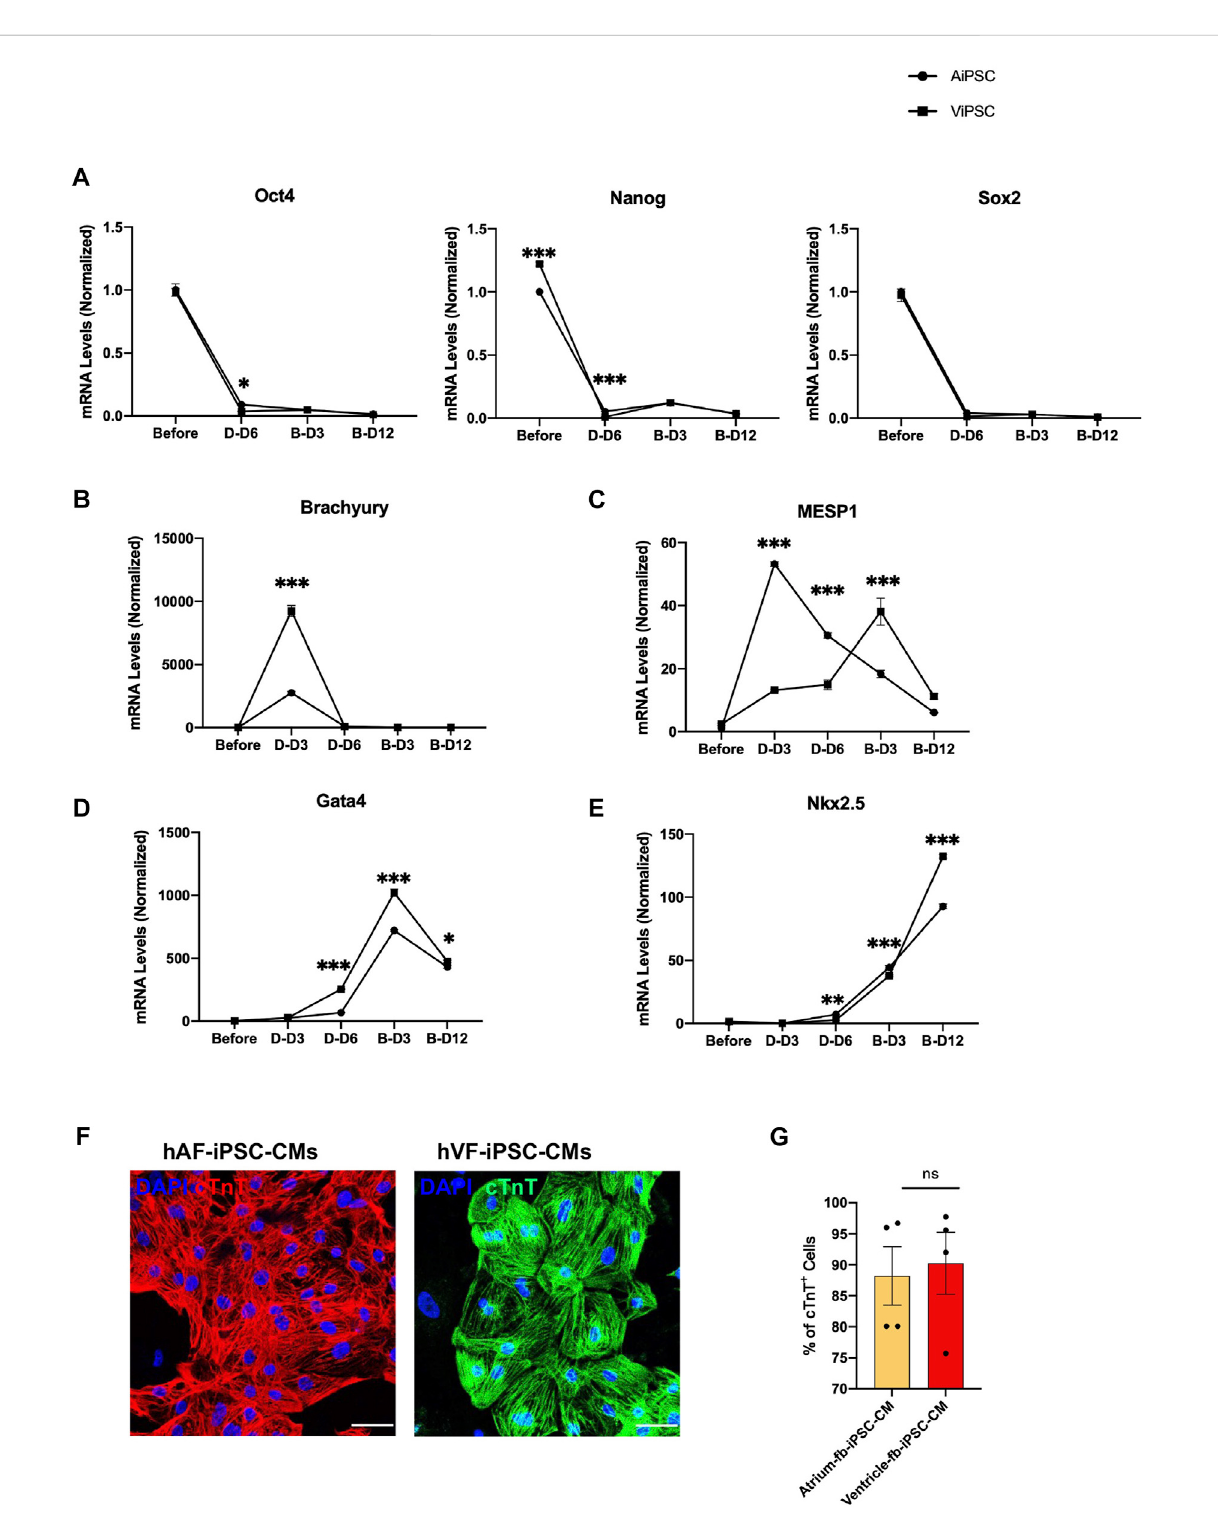
FIGURE 3 Differentiation of A iPSC and V iPSC into CMs was equally ef fi cient. A iPSC and V iPSC were differentiated into A iPSC-CM and V iPSC-CM via established protocols. The abundance of mRNA for (A) the pluripotency genes Oct4, Nanog, and Sox2; (B) the early mesoderm marker Brachyury, (C) the early cardiac-mesoderm marker Mesp1; and the cardiac-cell markers (D) Gata4 and (E) Nkx2.5 was evaluated before differentiation, 3 days (D-D3) and 6 days (D-D6)afterdifferentiationwasinitiated,and3 days(B-D3)and12 days(B-D12)afterbeatingwasobserved.Measurementswereperformed via qRT- PCR and normalized to the abundance of glyceraldehyde phosphate dehydrogenase mRNA (F) A iPSC-CM and V iPSC-CM were immuno fl uorescently stained for the expression of cardiac troponin T (cTnT); bar = 50 μ m. (G) The purity of the A iPSC-CM and V iPSC-CM was quanti fi ed via fl ow cytometry analyses of cTnT-expressing cells on B-Day 12. * p < 0.05, ** p < 0.01, *** p <